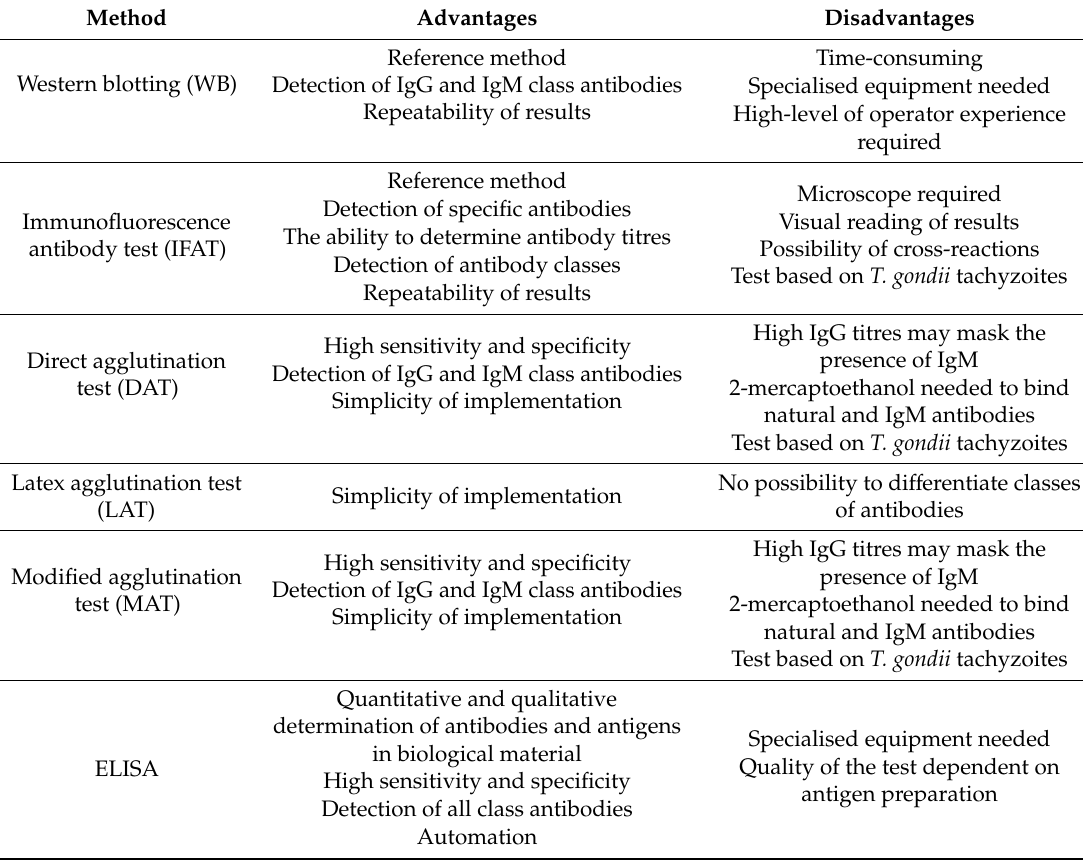
Table 1. Characteristics of tests used in serodiagnosis of toxoplasmosis in